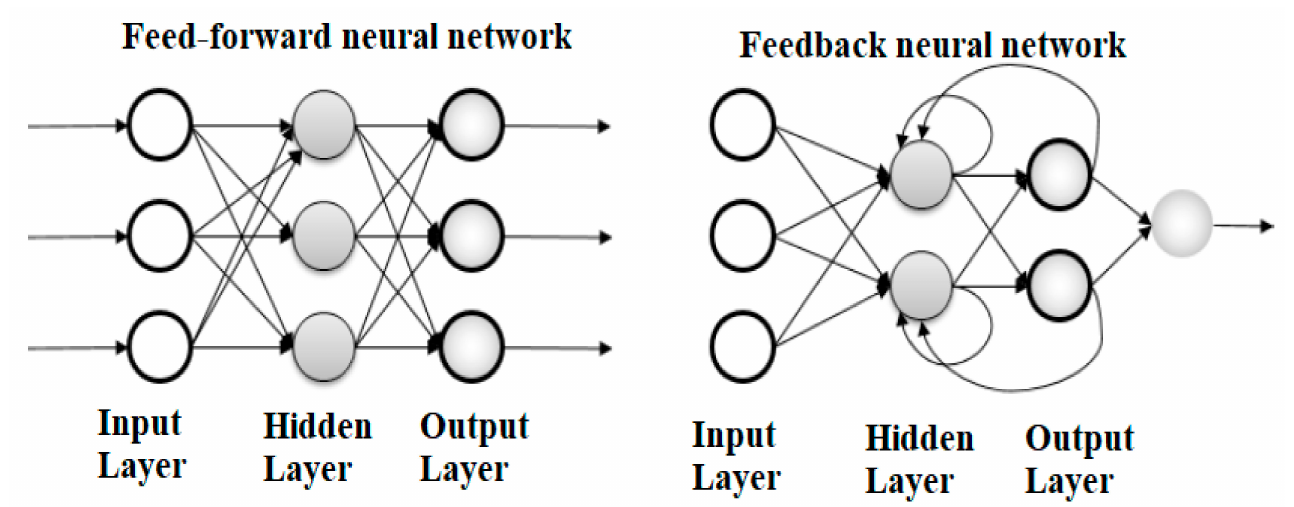
Figure 5. ANN architecture based on feed-forward and feedback neural networks [45].